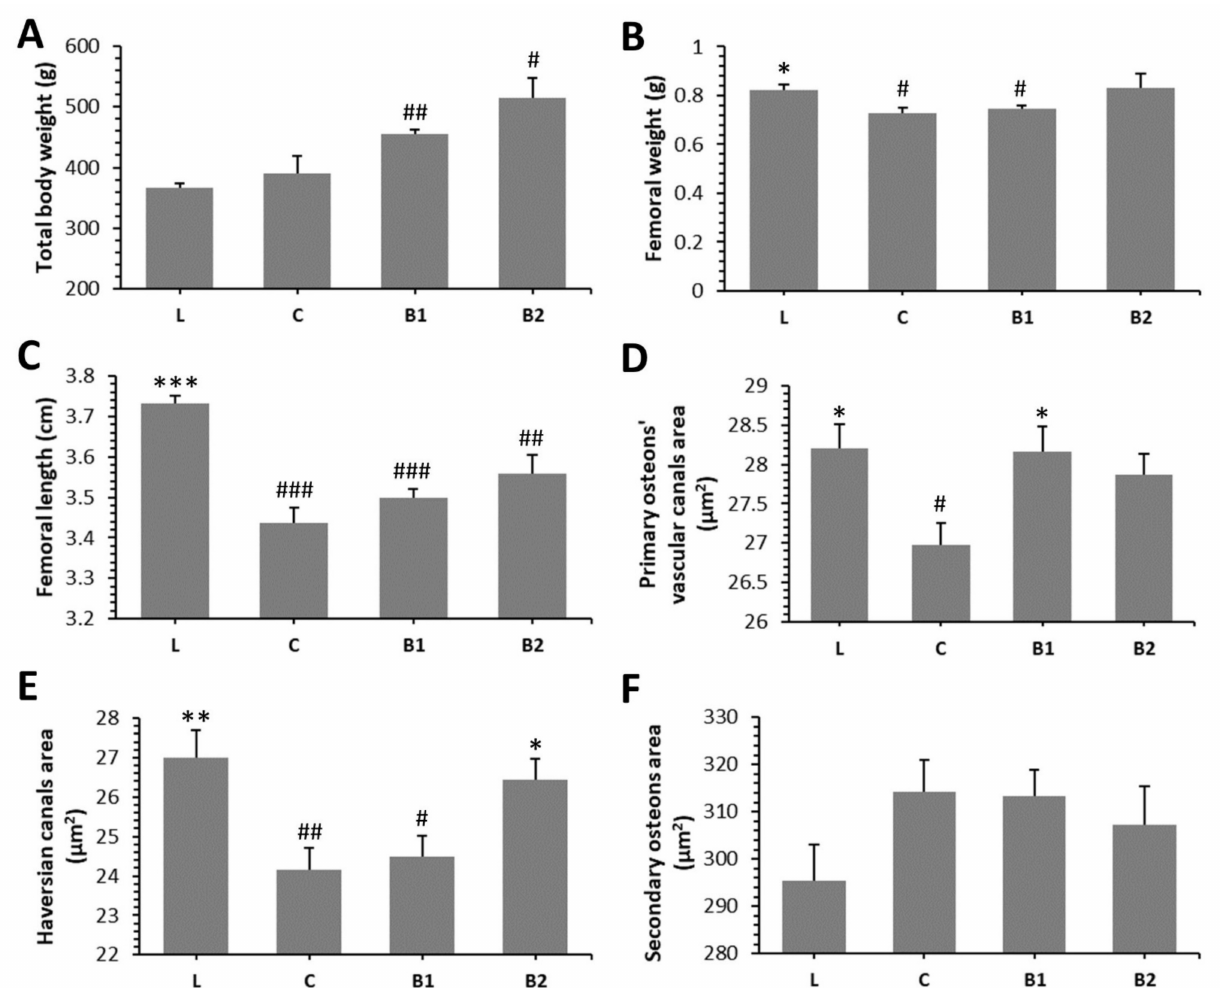
Figure 2. Impacts of BB on macroscopical ( A – C ) and morphological 2D ( D – F ) bone parameters in ZDF rats. * Significant dif- ferences compared with the C group ( p < 0.05), ** significant differences compared with the C group ( p < 0.01), *** significant differences compared with the C group ( p < 0.001), # significant changes in relation to the L group ( p < 0.05), ## significant changes in relation to the L group (p < 0.01), and ### significant changes in relation to L group ( p <